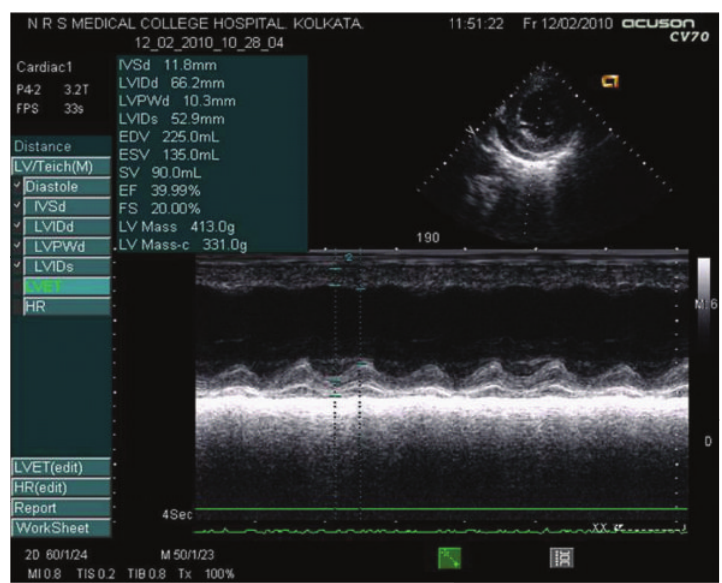
Figure 1: Pretreatment echocardiography showing severely depressed left ventricular systolic